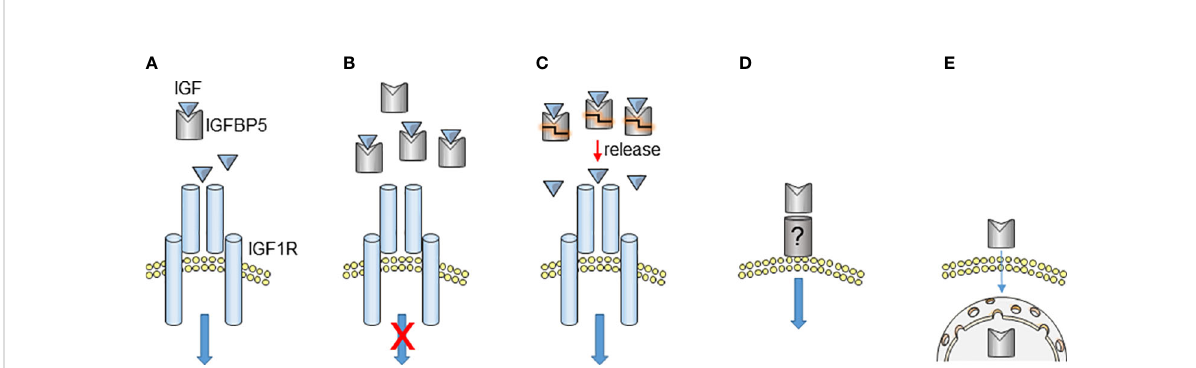
FIGURE 2 IGFBP5 actions. (A, B) By forming an inhibitory complex with IGF, IGFBP5 can prevent IGF-induced activation of IGF1R at appropriate IGFBP5/ IGF ratios. (C) IGF-bound IGFBP5 has also been suggested to function as an IGF storage complex. Sudden release of IGF due to IGFBP5 proteolysis can strongly increase the local IGF concentration, potentially enhancing the IGF effect on IGF1R. In this scenario, IGFBP5 acts as a promoter of IGF activity. (D, E) IGF-independent effects of IGFBP5 either caused by its interaction with a putative plasma membrane receptor (D) or caused by its ability to enter the cell and accumulate in the nucleus (E)